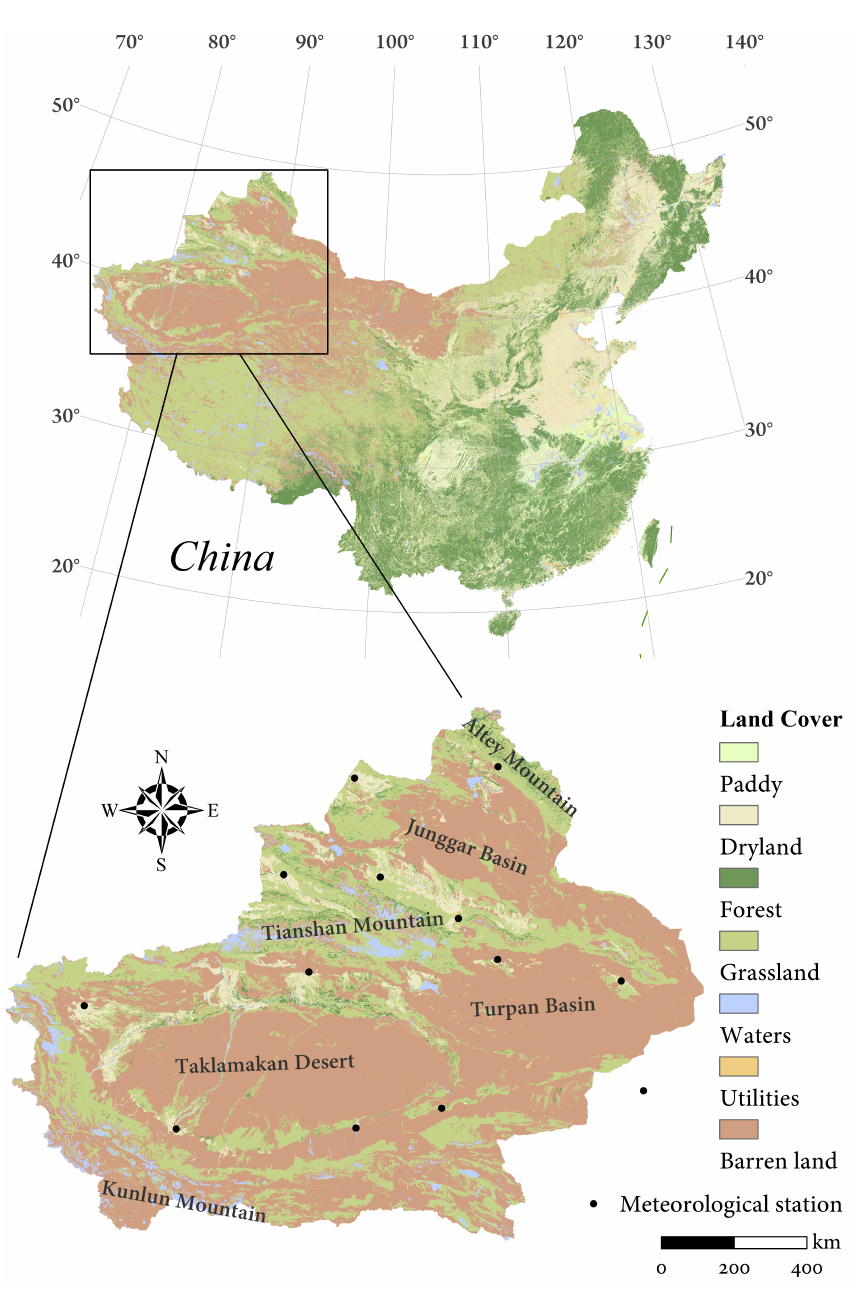
Figure 1. Land cover over Xinjiang region (2015) with its location in China as well as the geographical position of meteorological